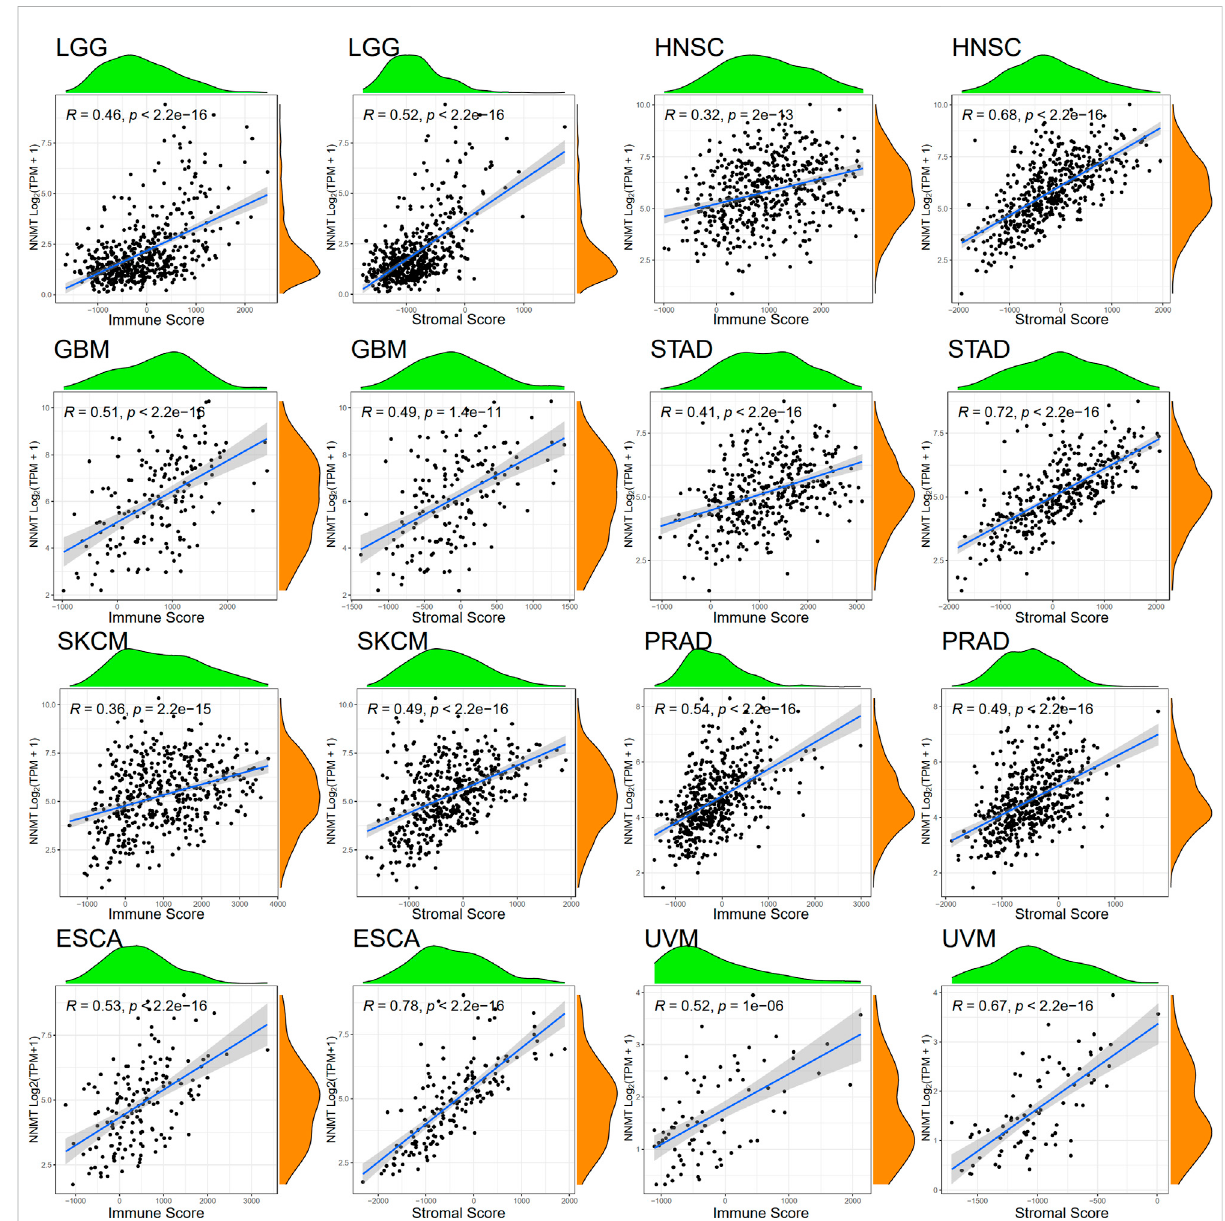
FIGURE 7 LGG, HNSC, GBM, STAD, SKCM, PRAD, ESCA, and UVM had the strongest signi fi cant correlation coef fi cients between the degree of tumor microenvironment and NNMT expression by Spearman ’ s rank correlation (immune scores and stromal scores,